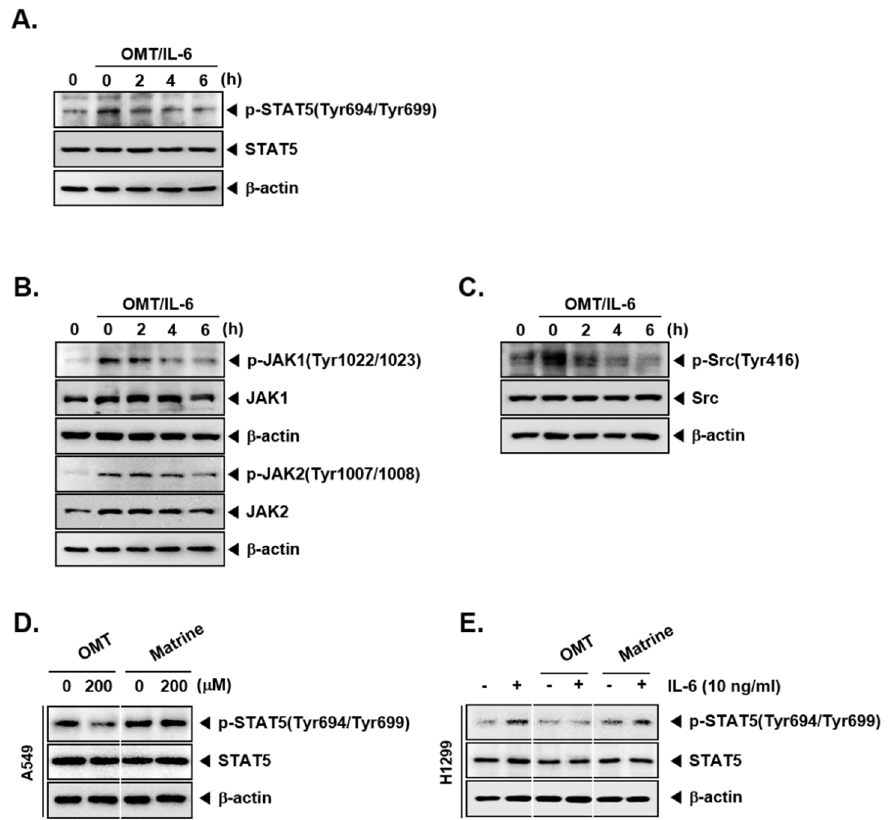
Figure 2. OMT can downregulate inducible STAT5 phosphorylation in H1299 cells. ( A – C ) H1299 cells (5 × 10 5 cells/well) were treated with 200 µ M OMT for indicated time intervals and then treated with IL-6 (10 ng/mL) for 15 min. Western blot analysis was performed as shown in Figure